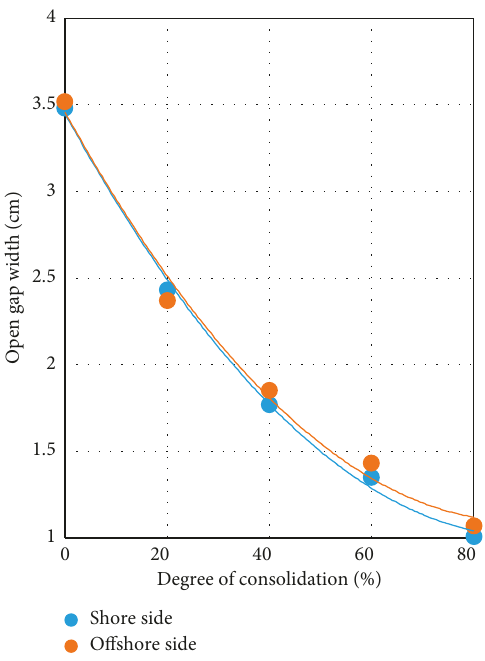
Figure 20: Variation rules for open gap of the sluice box culvert and sluice pier.